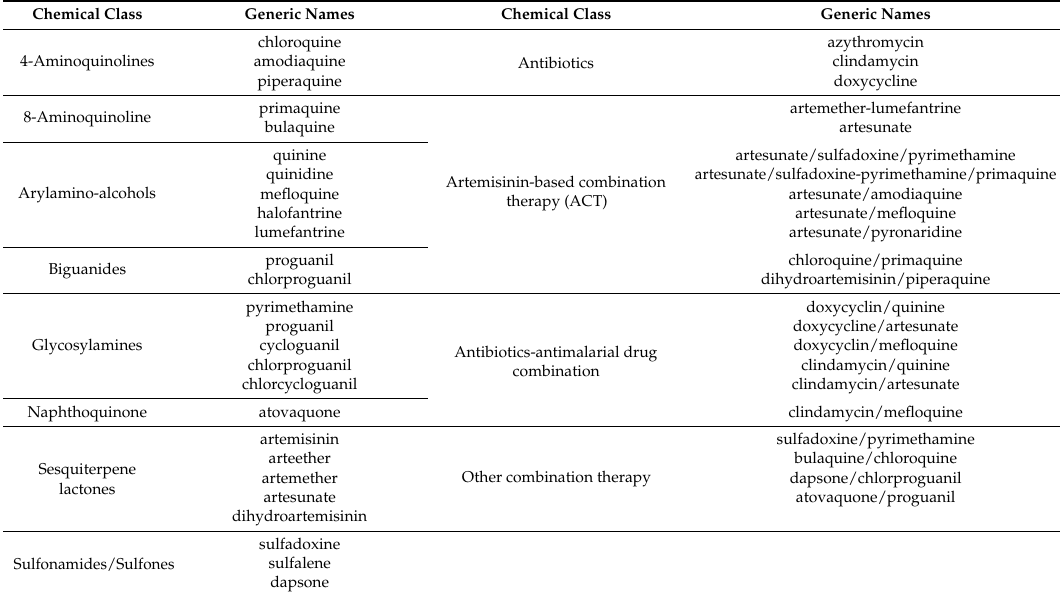
Table 1. Available antimalarial